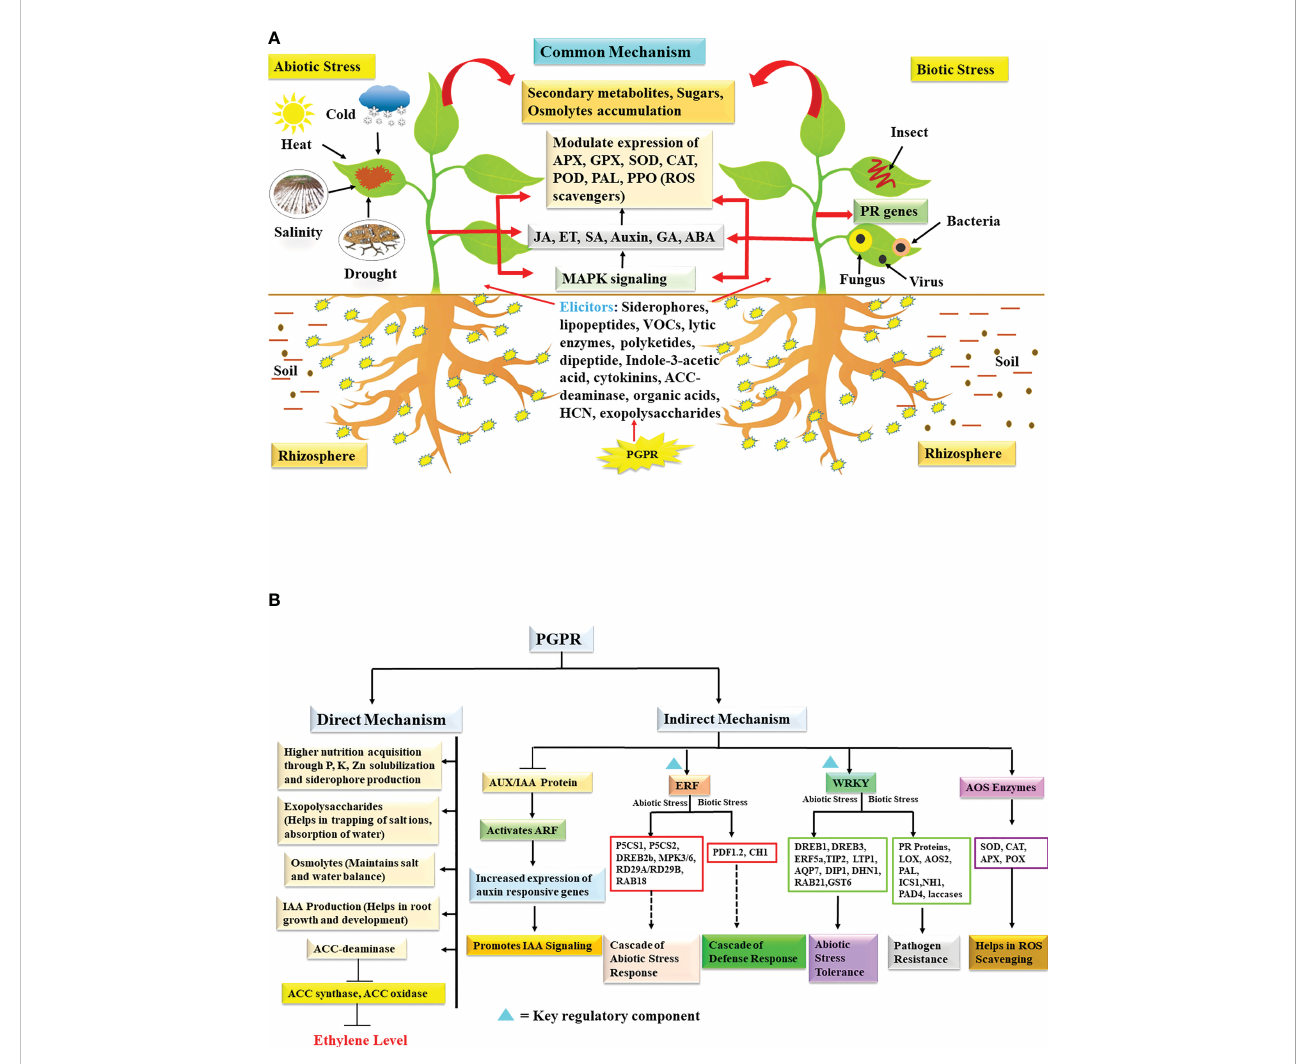
FIGURE 1 (A) Schematic representation of PGPR induced stress tolerance mechanism in plant challenged by abiotic and biotic stresses. Different elicitors released by PGPRs modulates endogenous phytohormones which in turn in fl uences secondary metabolites, osmolytes production, activity of antioxidant enzymes and PR proteins. These combined metabolic pathways imparts stress tolerance and promotes plant growth under stressed environment. (B) PGPR-based direct and indirect mechanism involved in activating cascade of abiotic and biotic stress signaling in plants. The activation events are represented by arrows, inhibition process is represented by bar while dashed arrows represent signaling cascade. IAA, indole-3-acetic acid; ACC, 1- Amino Cyclopropane-1-Carboxylate; AUX/IAA, auxin/indole-3-acetic acid; ARF, auxin response factor; ERF, ethylene response factor; P5CS1, D 1 - pyrroline-5-carboxylate synthase1; P5CS2, D 1 - pyrroline-5-carboxylate synthase 2; DREB2b/DREB1/DREB3, drought-responsive element binding protein 2b, drought-responsive element binding protein 1, drought-responsive element binding protein 3; MPK3/MPK6, mitogen – activated protein kinase 3, mitogen-activated protein kinase 6; RD29A/RD29B, response-to-desiccation 29A, response-to-desiccation 29B; PDF1.2, protodermal factor 1.2; CH1, chitinase; WRKY, W-box domain binding transcription factor; TIP2, tonoplast intrinsic protein 2; LTP1, lipid transfer protein 1; AQP7, aquaporin 7; GST6, glutathione S-transferase; DIP1, dehydration stress-inducible protein 1; DHN1, dehydrin 1; RAB21, responsive to ABA protein 21; PR, pathogenesis related proteins; LOX, lipoxygenase; AOS2, allene oxide synthase 2; PAL, phenylalanine ammonia lyase; ICS1, isochorismate synthase 1; NH1, Arabidopsis NPR1 homolog 1; PAD4, p hytoalexin-de fi cient 4; AOS, antioxidant scavenging; SOD, superoxide dismutase; CAT, catalase; APX, ascorbate peroxidase; POX, peroxidases; ROS, reactive oxygen